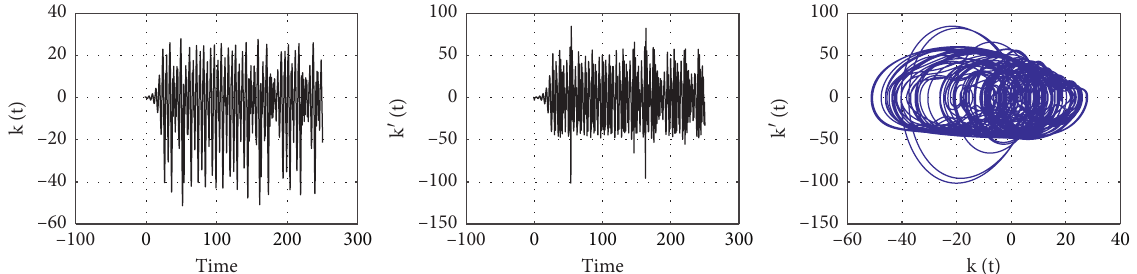
Figure 16: Solutions and phase trajectories at a � 0.125, q � 0.75, and τ � 2.